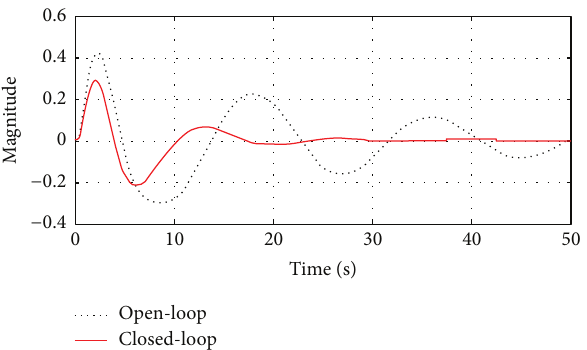
Figure 3: The responses of state variable 𝑥 2 (𝑡) .